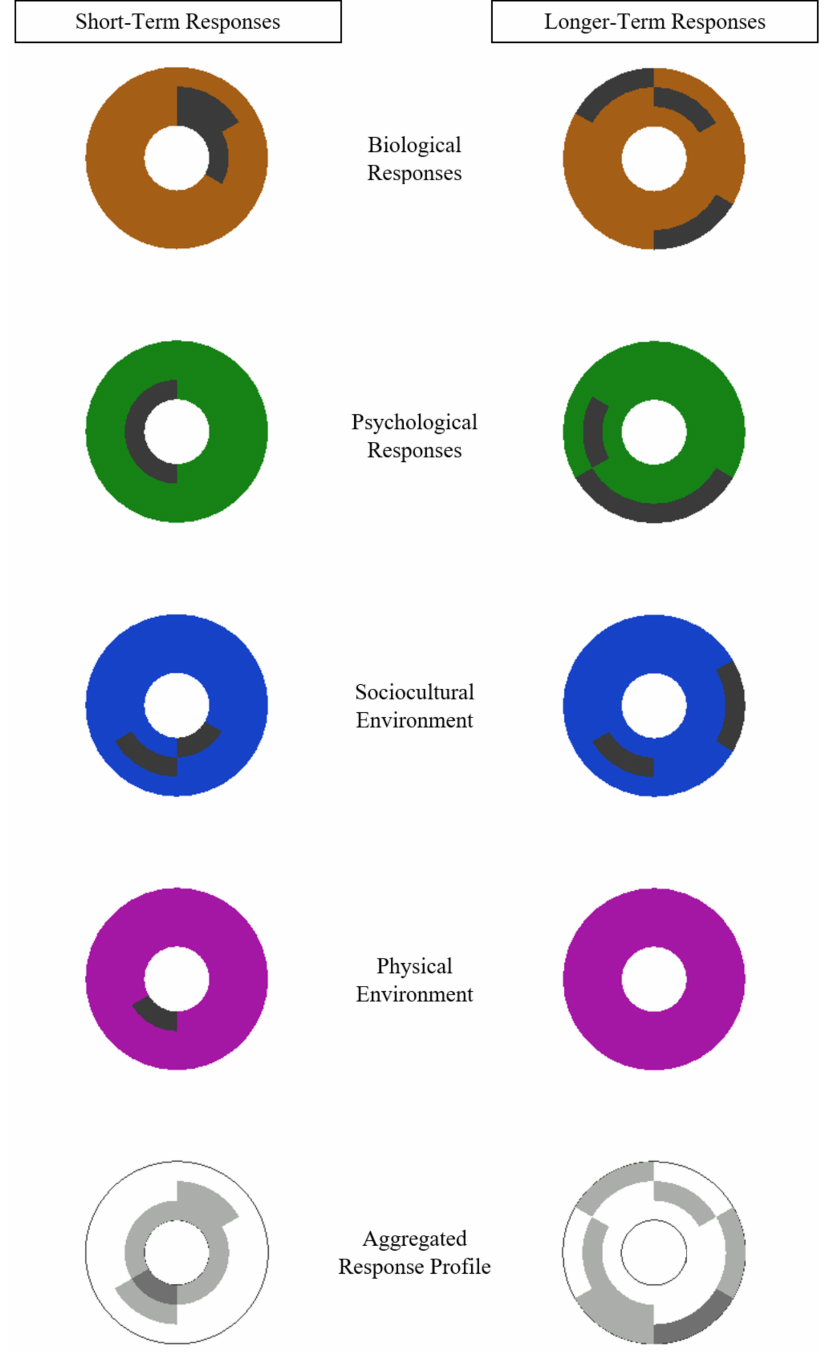
Figure 3. Top view of short-term (left column) and longer-term (right column) consequences in the sport injury antecedents and consequences visualization template. Darkened areas indicate elevated e ff ects of